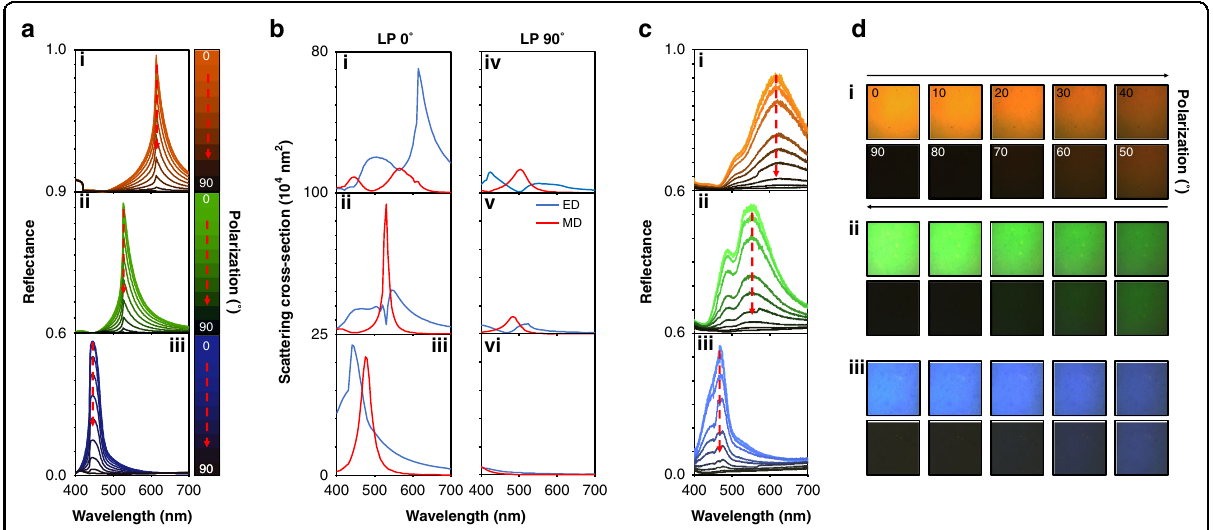
Fig. 2 Simulated re fl ectance and scattering cross-sections of the elliptical meta-atoms, and experimental results. a Simulated re fl ectance spectra of the polarization sensitive meta-atoms for (i) red, (ii) green, and (iii) blue colors with the incident light of linear polarization (LP) from along the long axis â (LP 0 ˚ ) to along the short axis b ̂ of the meta-atom (LP 90 ˚ ). As LP is modulated, the re fl ectance is gradually reduced, until a dark state is produced. b Calculated scattering cross-sections of the meta-atoms to produce (i) red, (ii) green, and (iii) blue colors under LP 0 ˚ . For red, the electric dipole (ED) is dominant, while for green the magnetic dipole (MD) is dominant, and for blue the ED and MD spectrally overlap. Under LP 90 ˚ , the scattering cross-sections for (iv) red, (v) green, and (vi) blue become almost negligible as quasi-guided modes are no longer supported and the scattering is unenhanced. c Measured re fl ectance spectra for (i) red, (ii) green, and (iii) blue metasurfaces with respect to LP axis from 0 to 90 o . d Corresponding optical micrographs of the 100 × 100 µm (i) red, (ii) green, and (iii) blue metasurfaces. The dotted black lines indicate the location of the Rayleigh-Wood